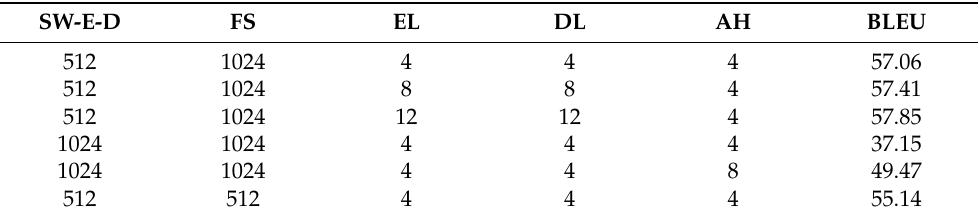
Table 6. Results of the Transformer-Based NMT Subword Model on corpus used by Baniata [22] for MAGHREBI–MSA translation task, where SW-E-D is the Subword embedding dimension, FS is the filter size, EL is the encoder layer, DL is the decoder layer and AH is the attention heads number.